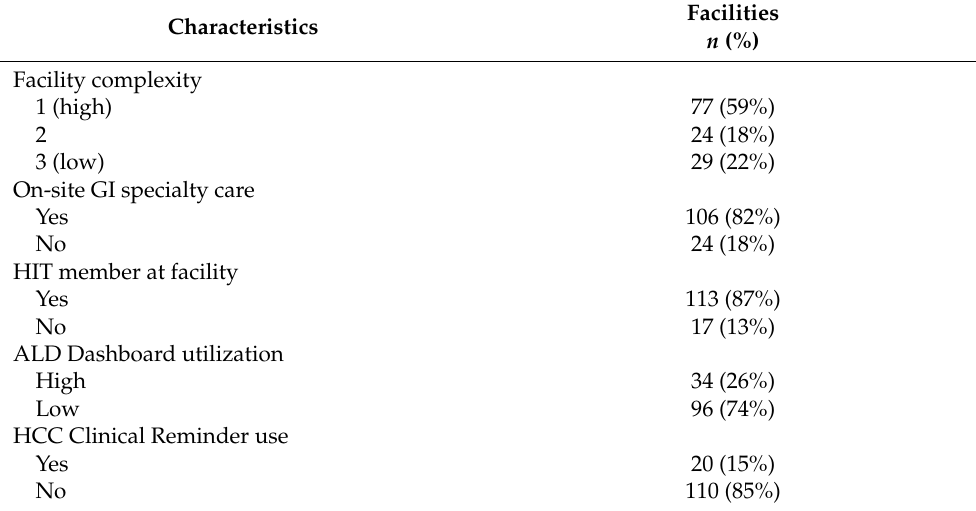
Table 1. Baseline Facility Characteristics ( n = 130)